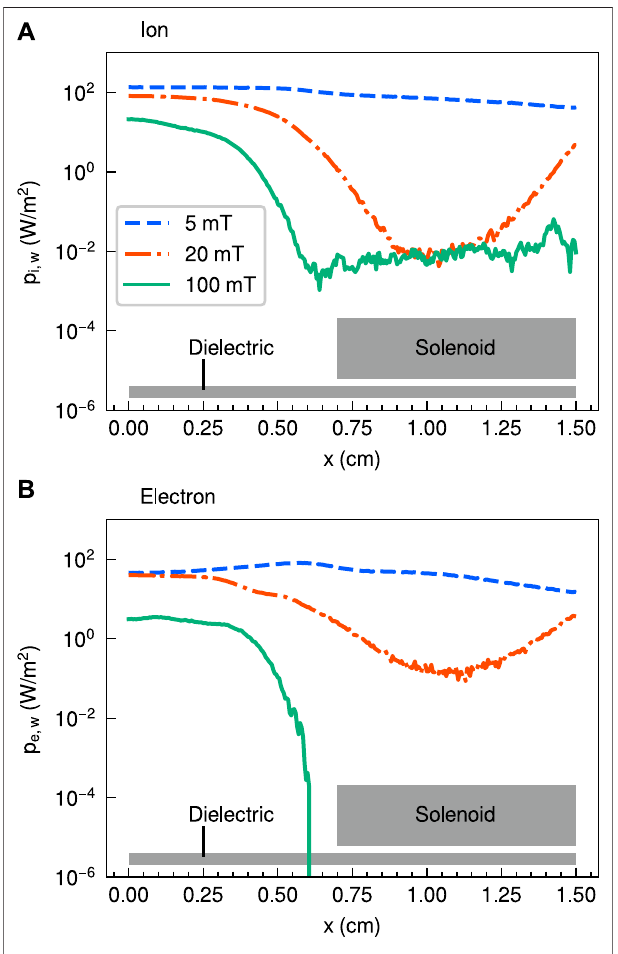
FIGURE 4 | x pro fi les of the (A) ion and (B) electron energy fl uxes on the lateral dielectric wall p i , w and p e , w , respectively, for the three magnetic fi eld strengths of 5 (a dashed blue line), 20 (a dotted-dashed orange line), and 100 mT (a solid green line). Gray boxes show locations of the solenoid and the lateral dielectric wall.